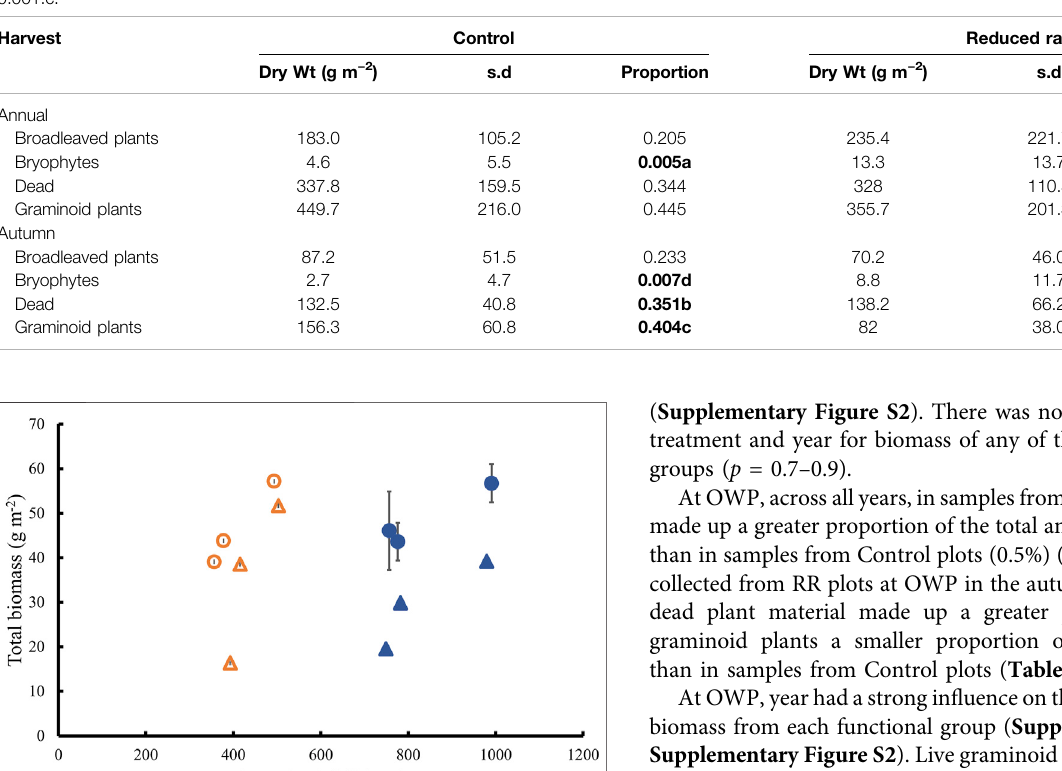
TABLE 2 | OWP the effect of Reduced Rainfall on the proportion of total dry biomass at OWP from each of dead material and live broadleaved plants, bryophtyes, and graminoid plants. Values in bold with the same letter are statistically signi fi cantly different from each other, based on pair-wise comparisons. At p (cid:2) 0.05:a, b, d; at p (cid:2) 0.001:c.